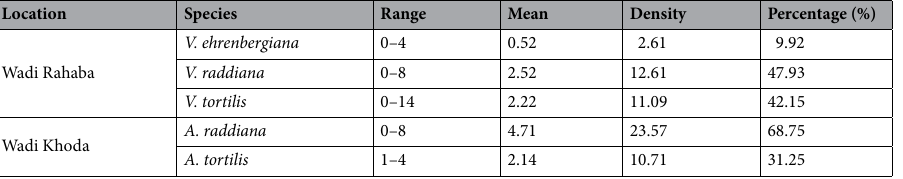
Table 1. Range in the number of Vachellia tree taxa, mean number of trees, density, and percentage of each taxa in the macroplots in wadi Khoda and wadi Rahaba, Gebel Elba National Park, south-eastern